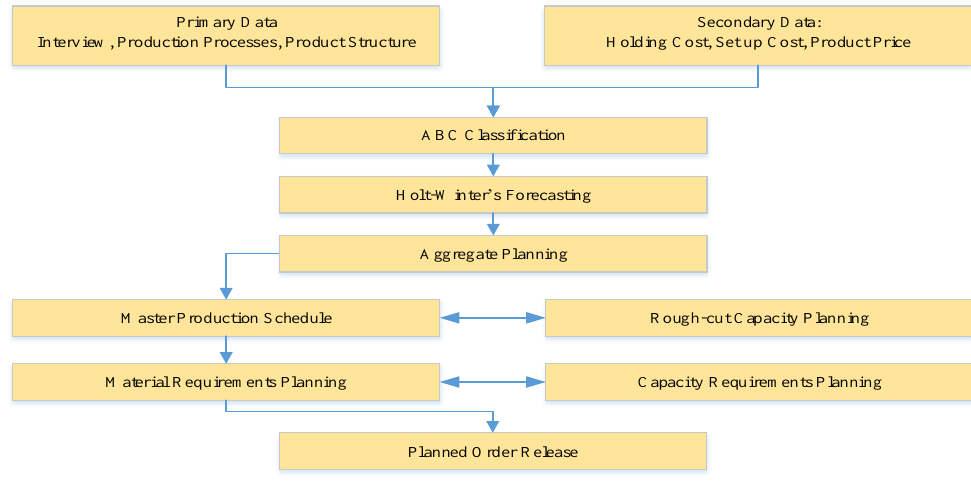
Fig. 2. Research flow chart.